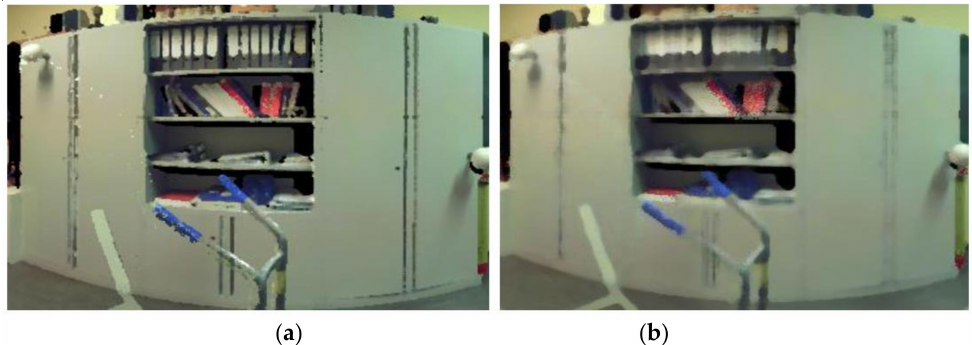
Figure 21. Noise removal with median filter and the filling of the upper area that had an overabun- dance of empty pixels: ( a ) before median filter and filling; ( b ) after median filter and filling.